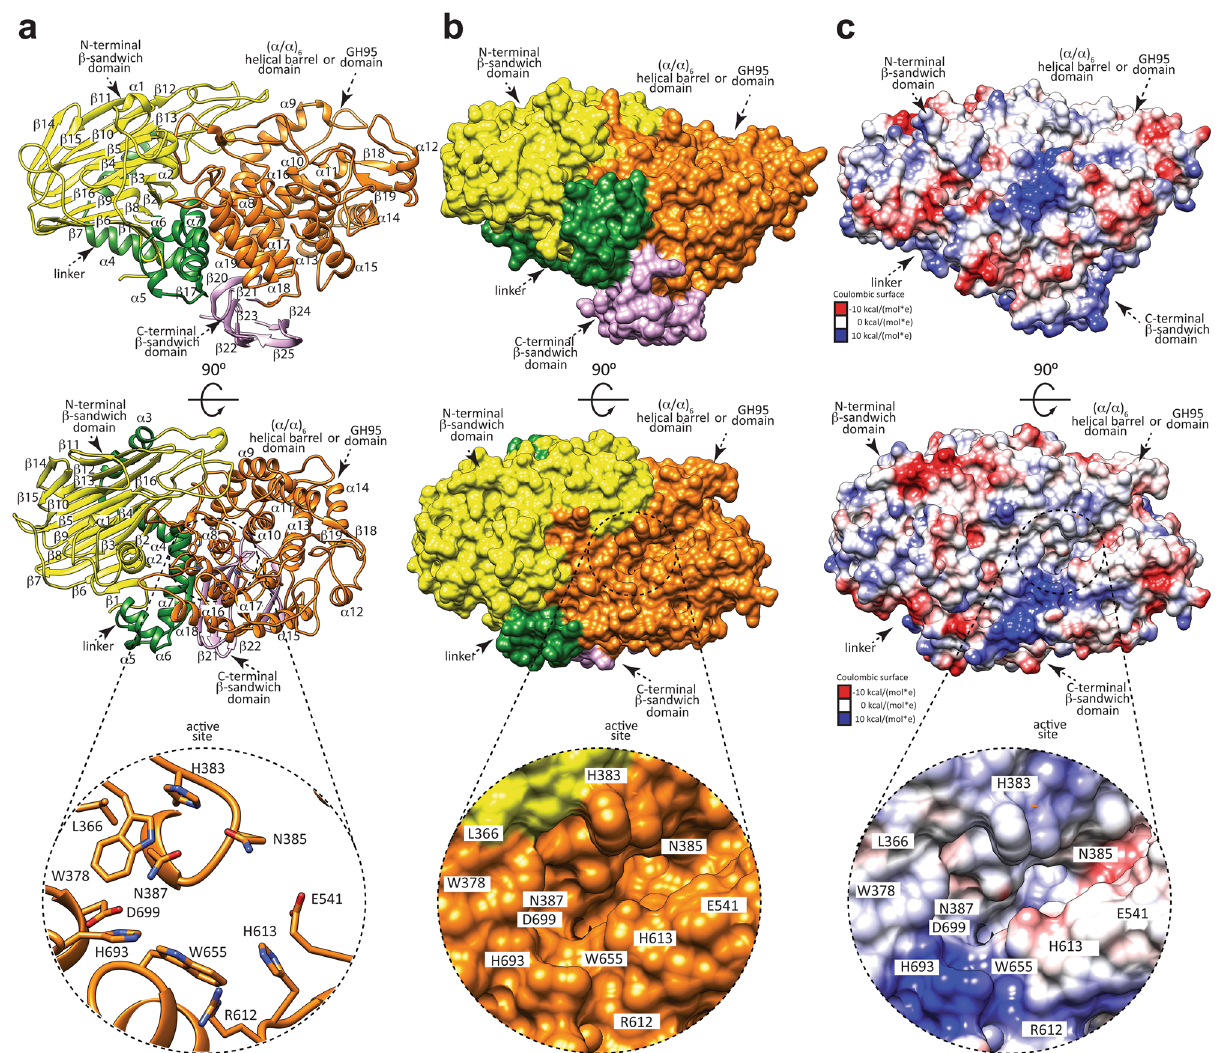
Fig.3|TheoverallstructureofFucOB.a Twoviewsofthecartoonrepresentation showingthegeneralfoldandsecondarystructureorganizationofFucOB,including thecatalytic( α / α ) 6 helicalbarreldomainorGH95catalyticdomain(orange)andthe N-andC-terminal β -sandwichdomains(yellowandpink,respectively).Thebottom panel corresponds to a close-up view of the active site, shown as a cartoon/stick representation. b Two views of the surface representation of FucOB. The bottom